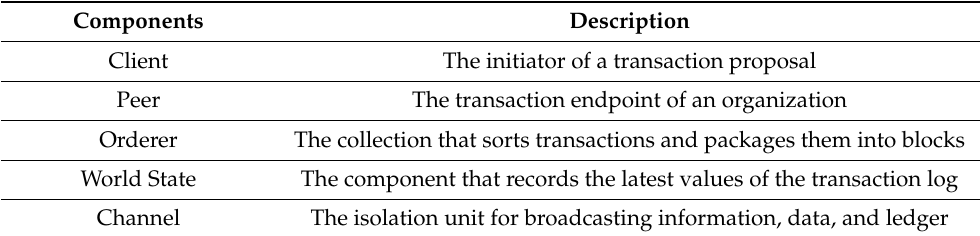
Table 2. Main components in a common transaction workflow.